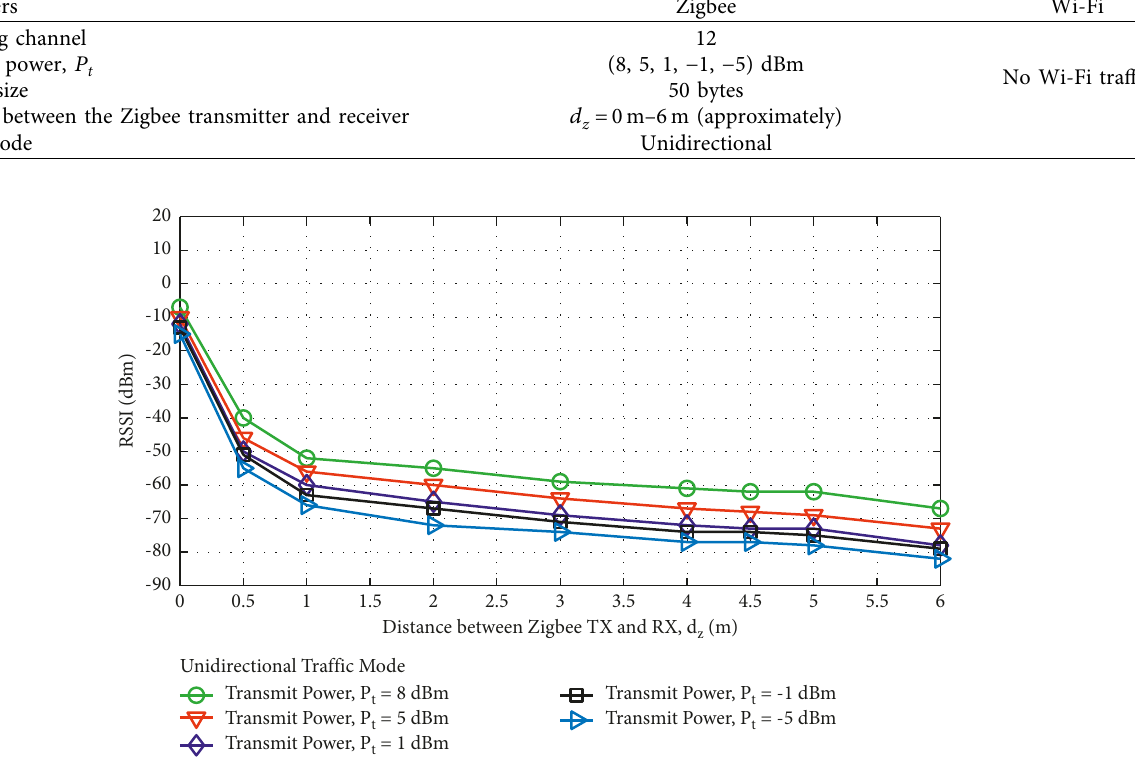
Figure 6: RSSI versus d z for a range of transmit